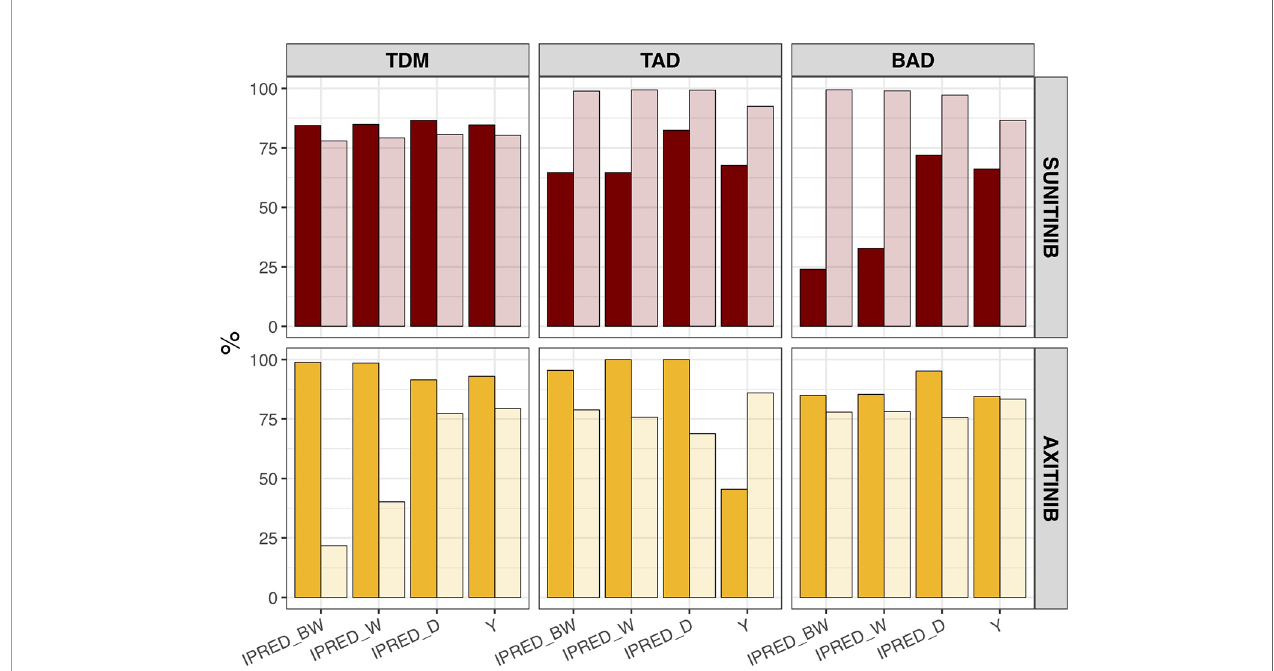
FIGURE 4 | Sensitivity and speci fi city of dose decisions based on biomarker forecasts (IPRED) versus clinical sample-based methods (Y). Percentage of correct dose recommendations in the simulated population (n = 1,000) in model-based biomarker forecasts (IPRED) or directly measured sample values (Y) under continuous bidaily dosing of axitinib at 5 mg or daily dosing of sunitinib at 37.5 mg. Each plot represents the dose recommendation at week 8 under different sampling frequencies (biweekly [IPRED_BW], weekly [IPRED_W] or daily [IPRED_D]; on x-axis). For directly measured clinical samples (Y on x-axis) each plot represents the dose recommendation at week 8, following one measurement at baseline and one at week 8. Sensitivity = [amount of times dose increases/amount of times dose should have been increased according to biomarker value] × 100%. Sensitivity is represented by the dark shaded bars. Speci fi city = [amount of times dose did not increase/amount of times dose should not have been increased according to biomarker value] × 100%. Speci fi city is represented by the light shaded bars. BAD, biomarker-based dosing; TAD, toxicity-adjusted dosing (ANC for sunitinib; dBP for axitinib); TDM, therapeutic drug monitoring.